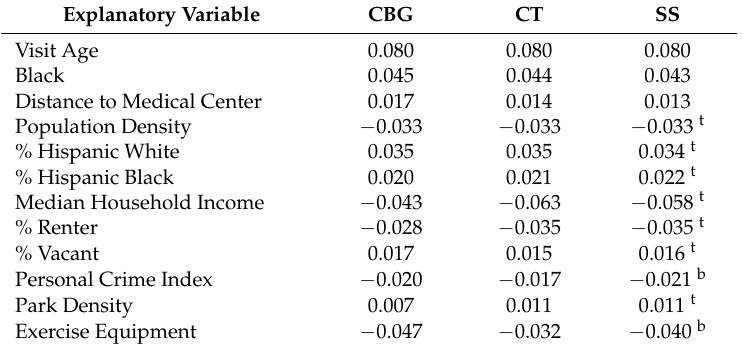
Table 5. OLS coefficient estimates for three models based on covariates that were selected by the spatial scale (SS) forward stepwise model of BMI z-score: (1) when constraining all selected area-level covariates to enter at the CBG level; (2) when constraining all selected area-level covariates to enter at the CT level; and (3) when allowing all selected area-level covariates to enter at the model-selected spatial scale. The horizontal dashed line separates the individual-level variables and the area-level